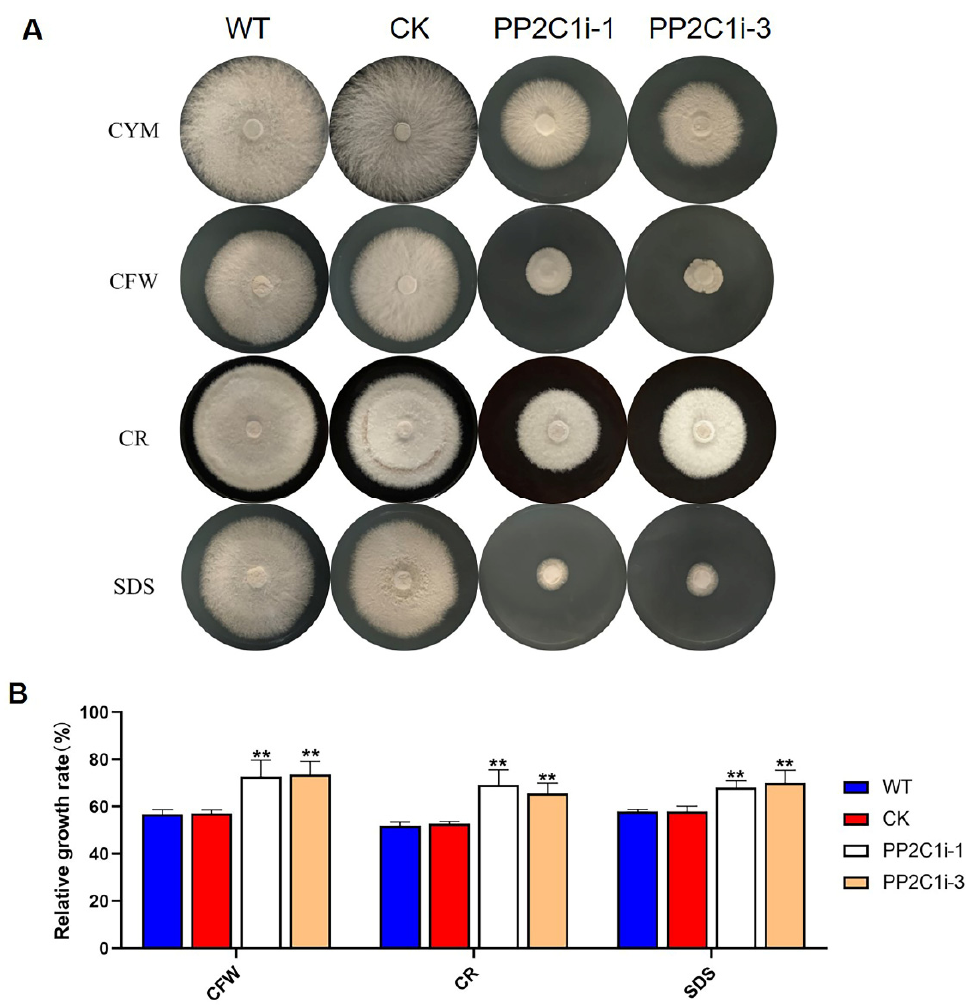
Figure 3. Sensitivity of PP2C-silenced strains to cell wall-disrupting compounds. ( A ) The PP2C- silenced, WT and CK strains were cultured on CYM plates under different cell wall stresses. ( B ) Rel- ative growth rates of the tested strains under cell wall stress in the PP2C-silenced, WT and CK strains. The relative growth rates (%) of the different strains in the presence of the indicated stressors were calculated as the colony area on stressor-containing medium versus the colony area on CYM. The data are presented as the means ± SDs from three independent experiments ( ** p < 0.01 by one-way ANOVA).